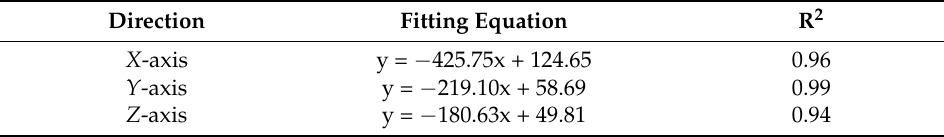
Table 3. Triaxial modulus of elasticity fitting equation.